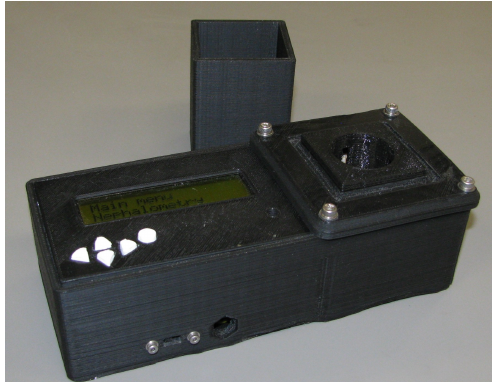
Figure 6. 3-D printable open-source mobile water quality testing platform capable of both colorimetry for biochemical oxygen demand/chemical oxygen demand and nephelom-